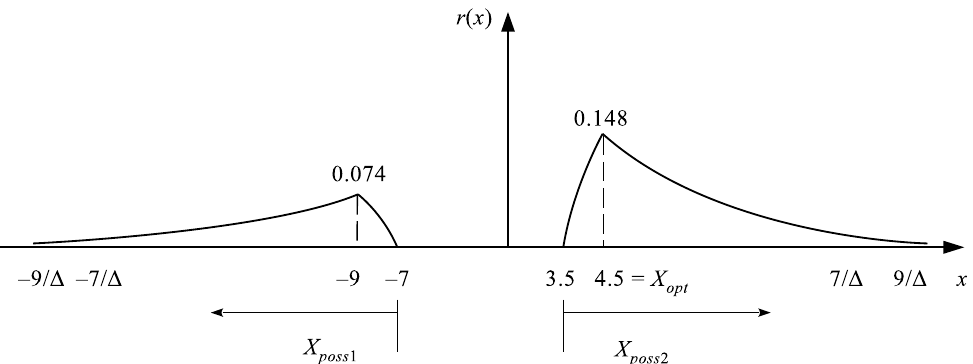
Figure 16. Robustness distribution r ( x ) of control x for possible changes of the disturbance a ∈ [ − 1,0,2 ] of the system [ − 1,0,2 ] x = [ 7,9 ] , together with the optimal control value x opt =